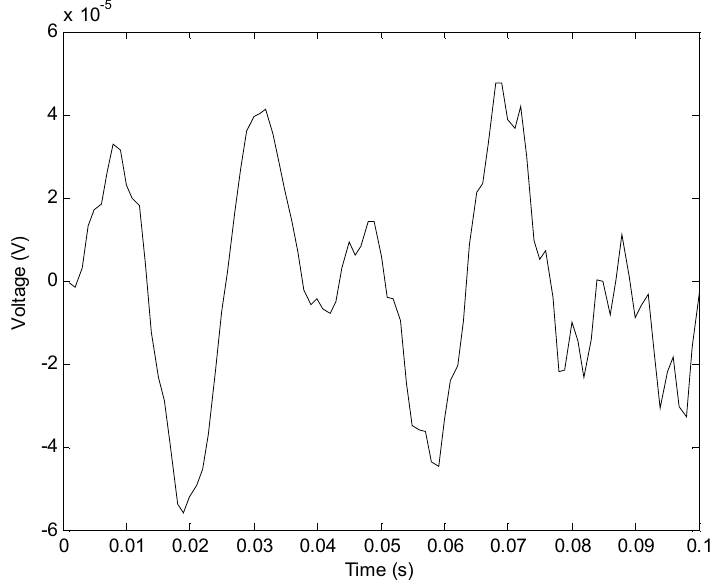
Fig. 11. PZT sensor voltage for the non-rotating system. An upward step force is acting at the tip of the opposite